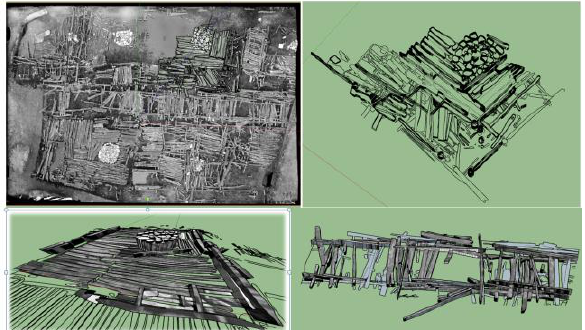
Figure 5: Archival photographs: a) nadir and oblique